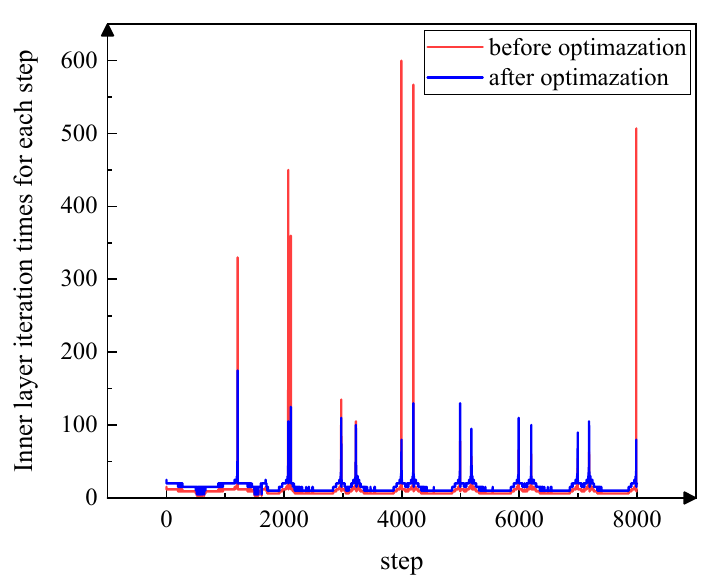
Figure 5. Number of iterations at each step before optimization and after optimization.